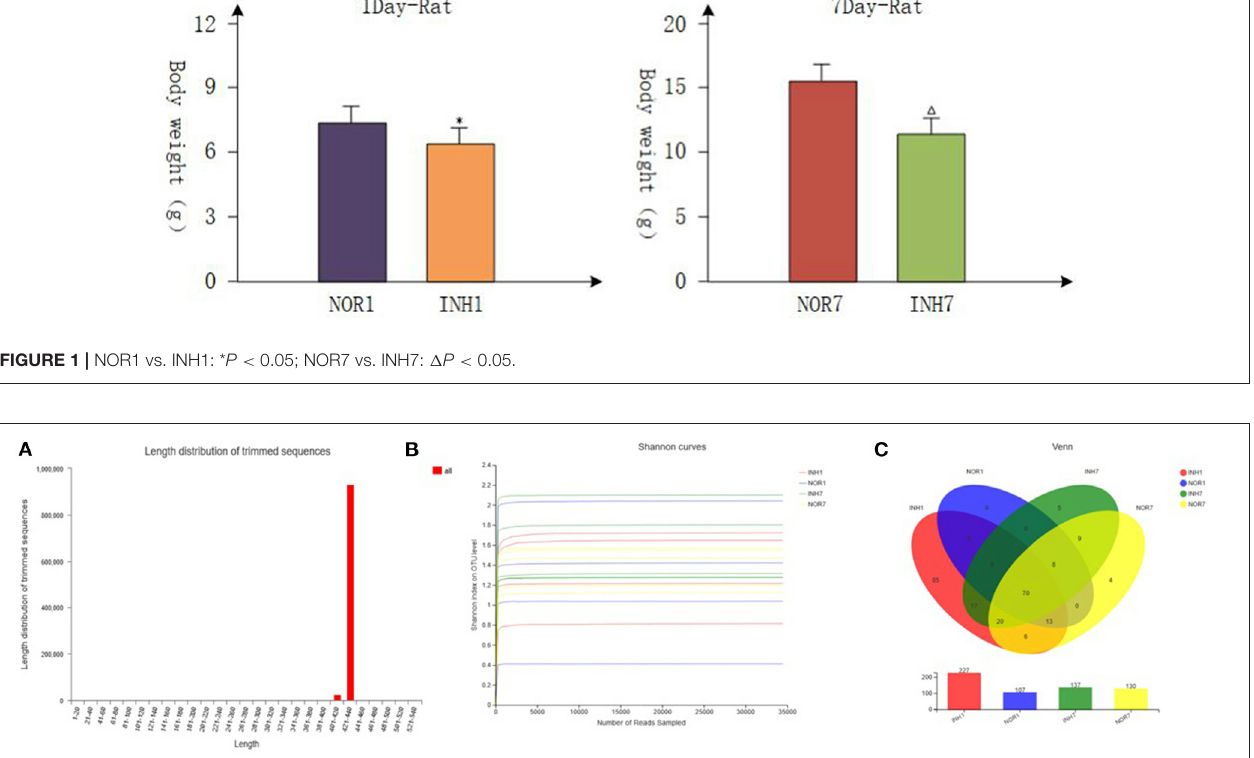
FIGURE 2 | (A) Sequence length distribution diagram. The X-axis represents the length interval, and the Y-axis represents the number of sequences. (B) Alpha-diversity Shannon index dilution curve, with the horizontal axis representing the amount of randomly selected sequencing data and the vertical axis representing the number of observed species. (C) A Venn diagram that can be used to count the number of common and unique species in multiple groups of samples, which can intuitively show the similarity and overlap of species composition in different environmental samples. Different colors represent different groups, overlapping numbers represent the number of species common to multiple groups, and non-overlapping numbers represent the number of species unique to the corresponding group.